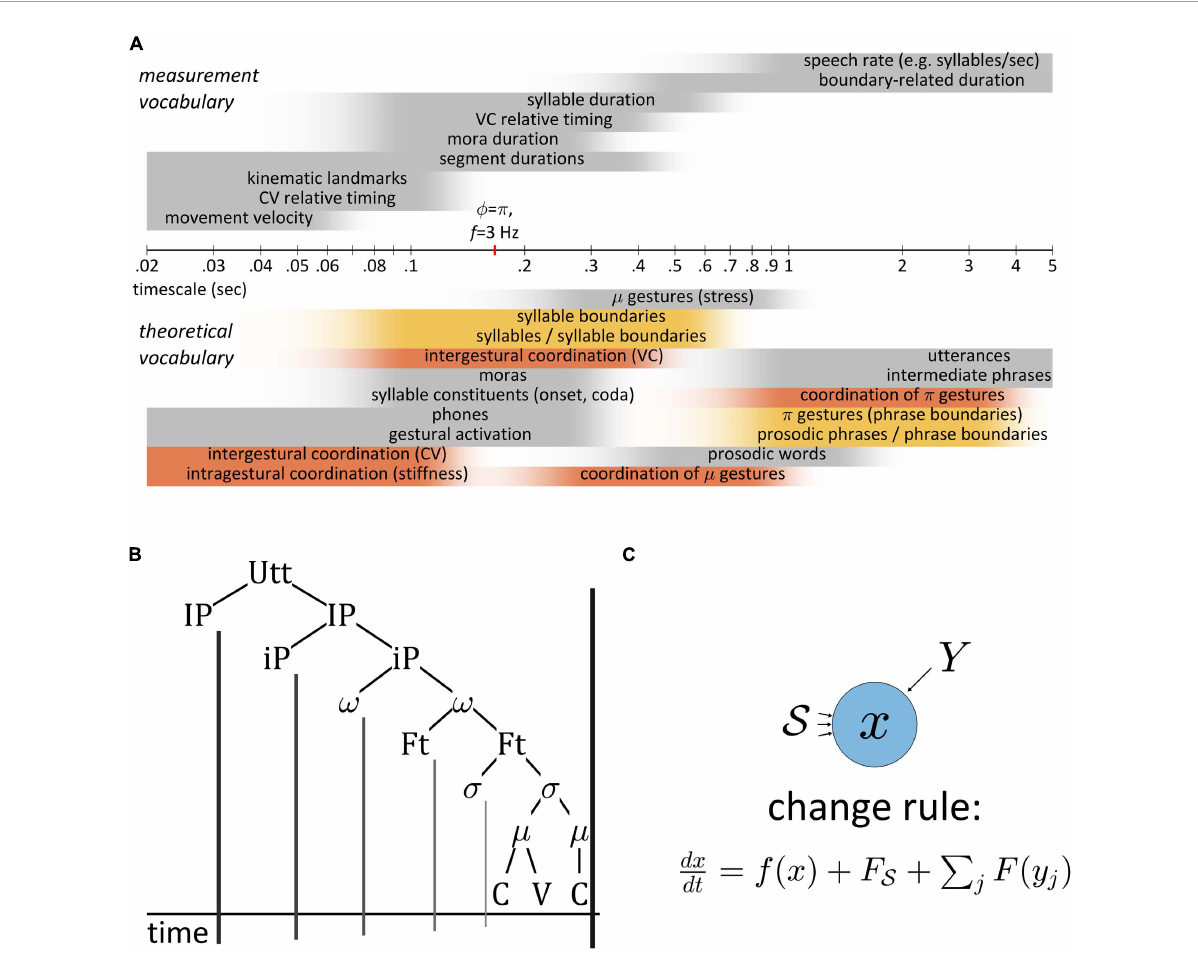
FIGURE2 (A) Comparison of timescales associated with various measurements and theoretical constructs used to conceptualize temporal patterns. Time axis is logarithmic. Shaded intervals approximately represent ranges of time in which terminology applied. (B) Hierarchical conception of prosodic structure and implicit projection of units to boundaries in a temporal coordinate. (C) Generic system schema, where change in the state variable x is a function of x itself and of forces from the surroundings S and from other systems Y .